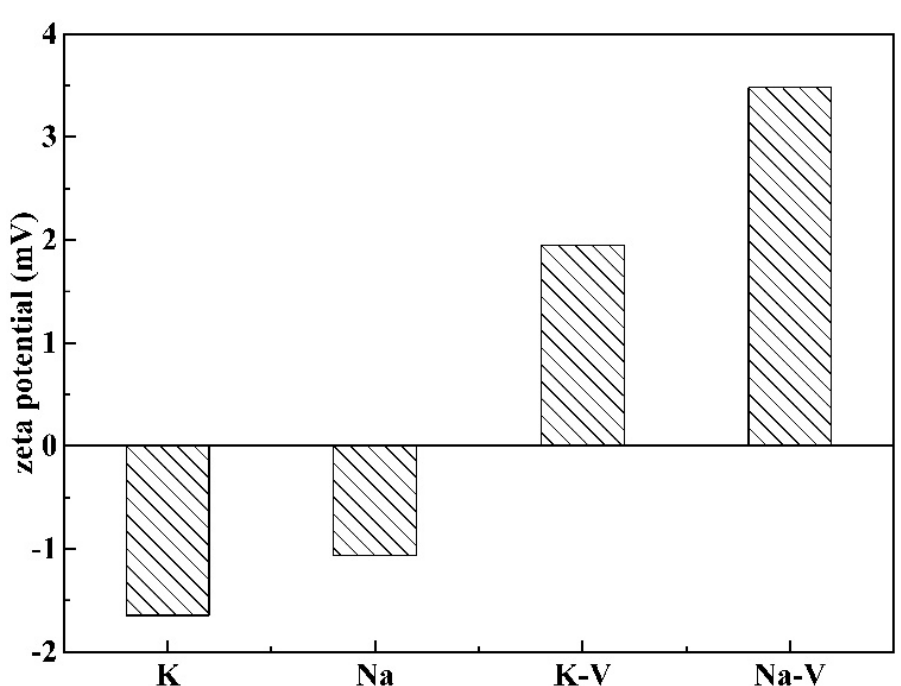
Figure 15. The zeta potentials of the precipitates at a pH value of 0.6 ((K) alunite; (Na) natroalunite; (K-V) alunite with co-precipitated vanadium; (Na-V) natroalunite with co-precipitated vanadium).